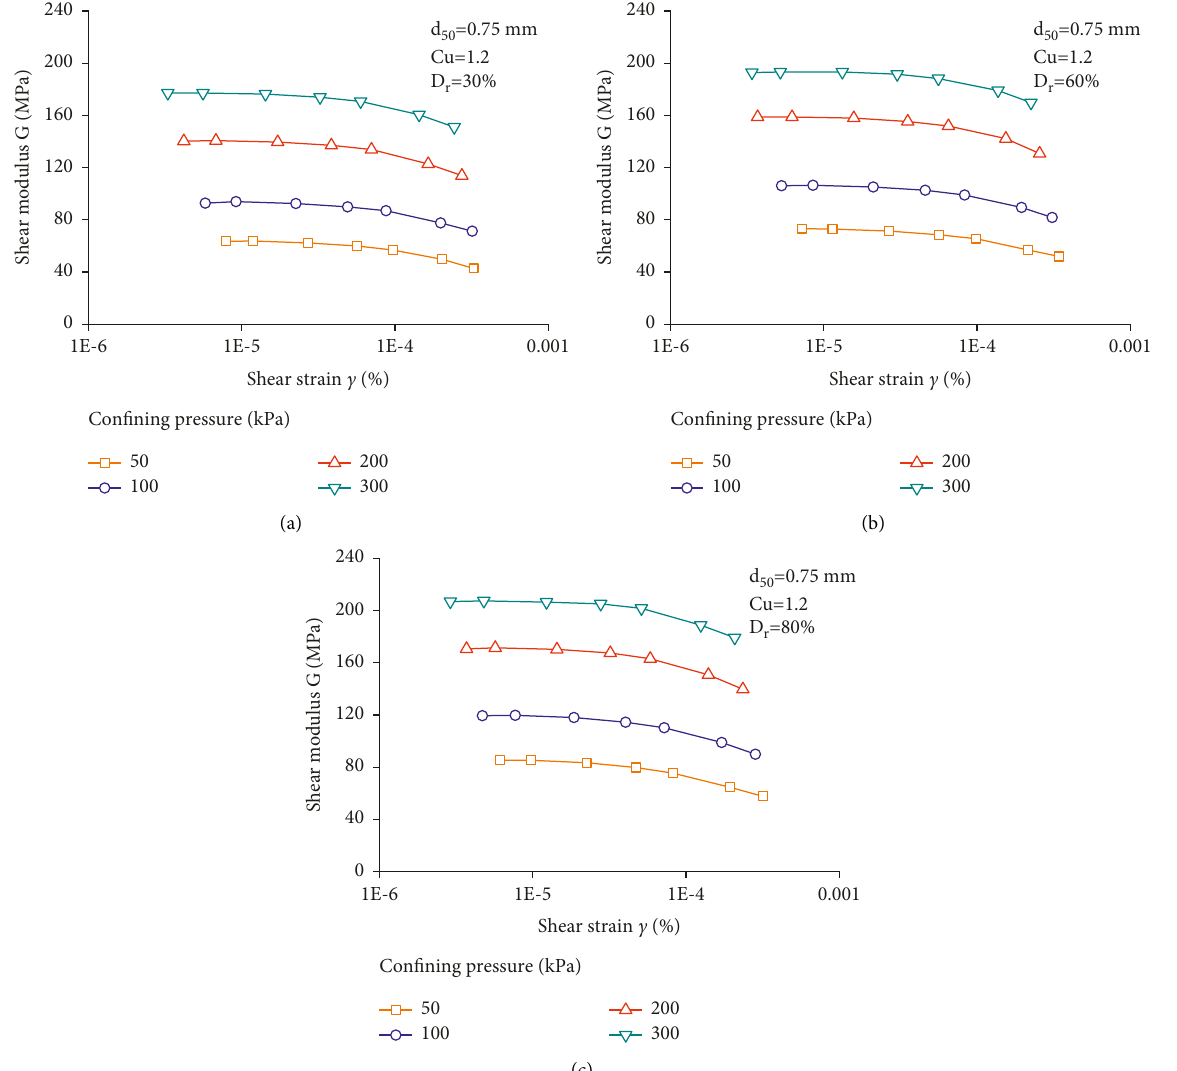
Figure 3: Shear modulus G and shear strain c for calcareous sand with d (a) Loose state. (b) Medium dense state. (c) Dense